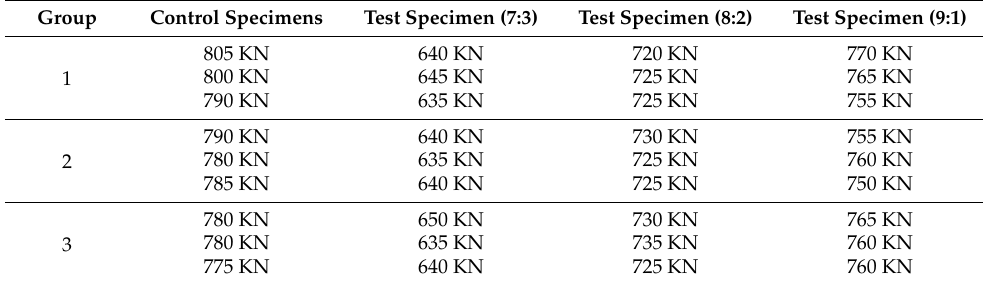
Table 4. Main crushing indicators.